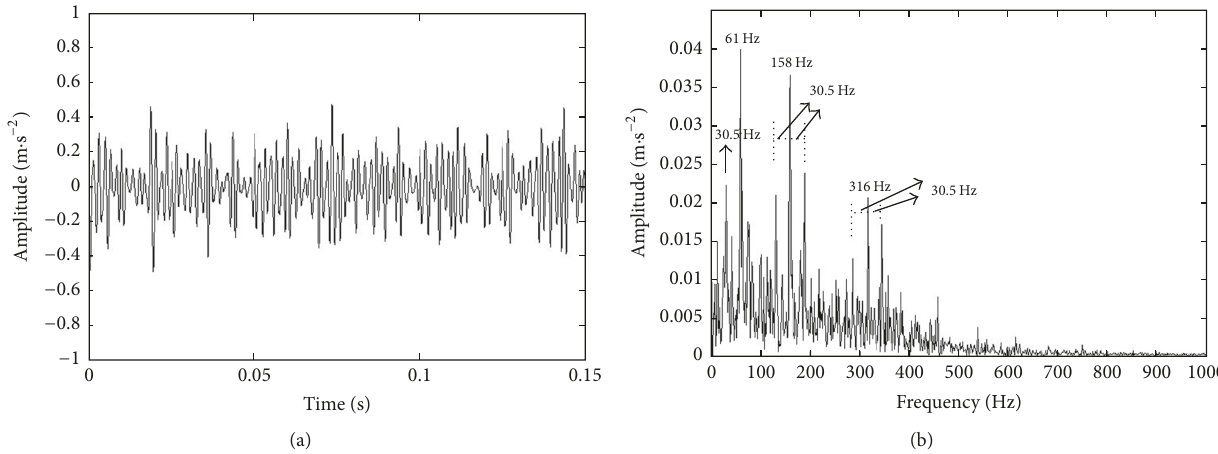
Figure 3: Denoising by thresholding function using QSD based on SGMM: (a) waveform in the time domain; (b) frequency spectrum.